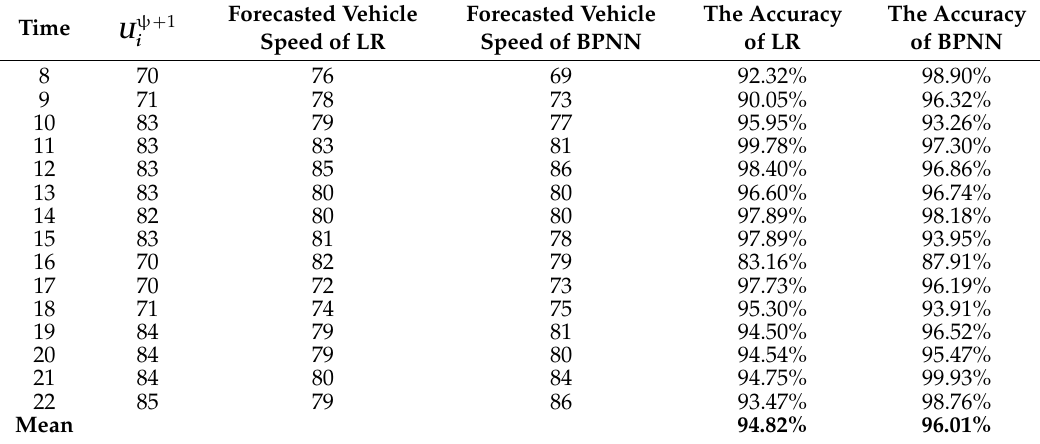
Table 8. The accuracies of vehicle speed forecasting of the road segment covered by Cell 1 . LR, logistic regression.